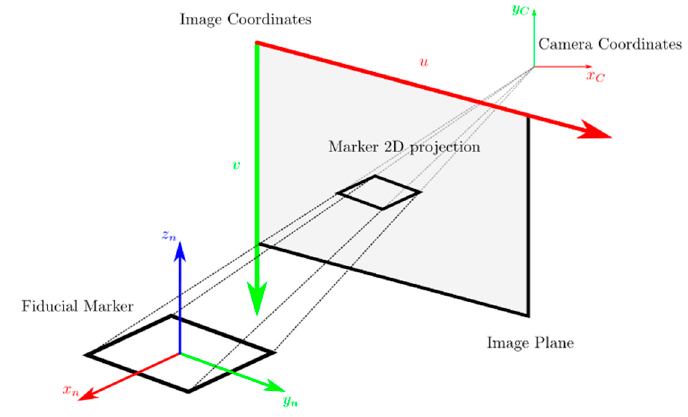
Figure 4. Pinhole camera model applied to a single square marker. The camera model allows the image projection to be represented in the 3D environment, or vice-versa.